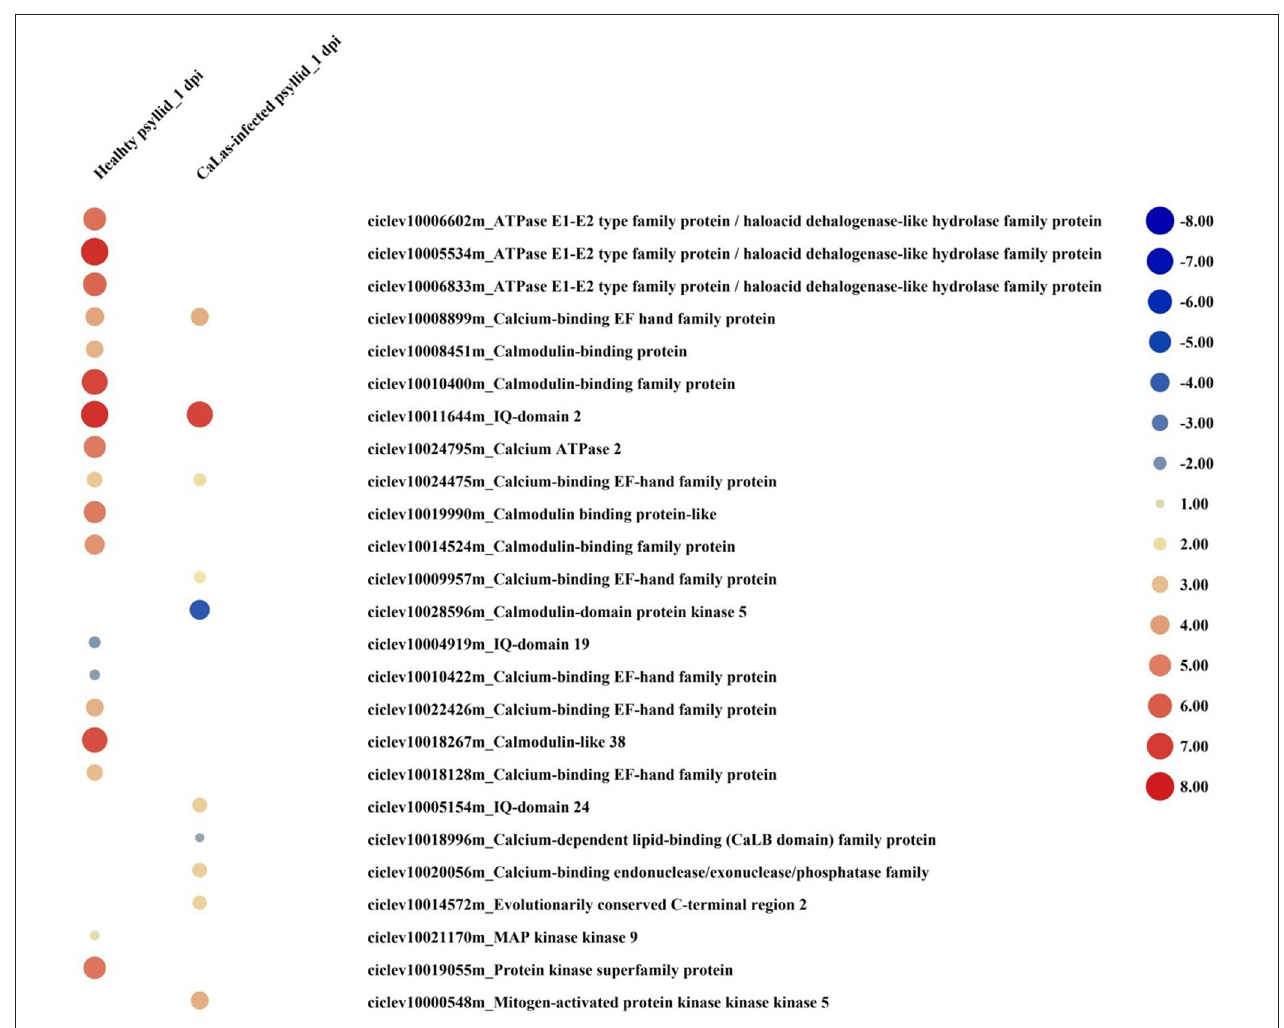
FIGURE 5 | The red-blue heatmap of modulated DEGs involved in “signaling calcium” and “signaling MAP kinases” pathways. Each DEG is depicted by a color signal where red signifies upregulation and blue signifies downregulation. The size of each spot indicates the level of expression.